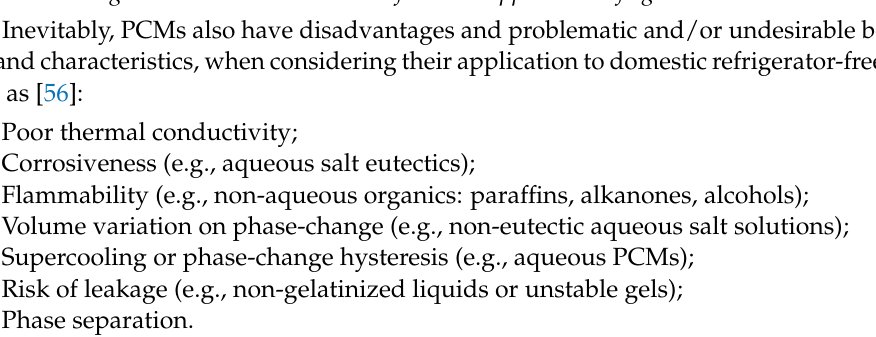
Figure 8. Comparison of the specific capacity of a eutectic KCl+H2O PCM with a lead-acid battery [57,59,60].